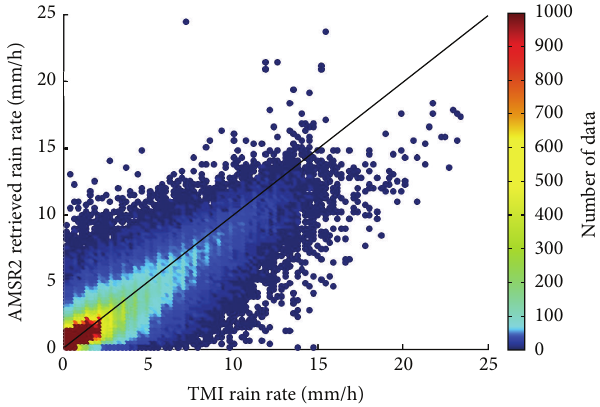
Figure 7: Scatter plot of rain rate, retrieved from GCOM-W1 AMSR2 using newly developed algorithm, versus TMI rain rate (Remote Sensing Systems daily product) for the period of August 2012–April 2014. Time collocation is within 10